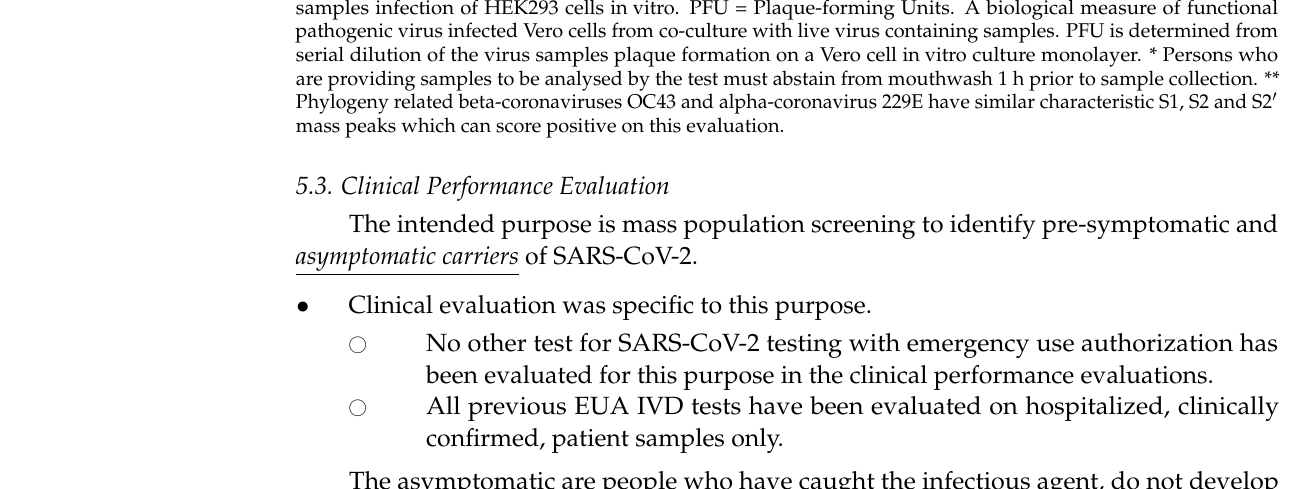
Positive Samples Negative Samples Detected